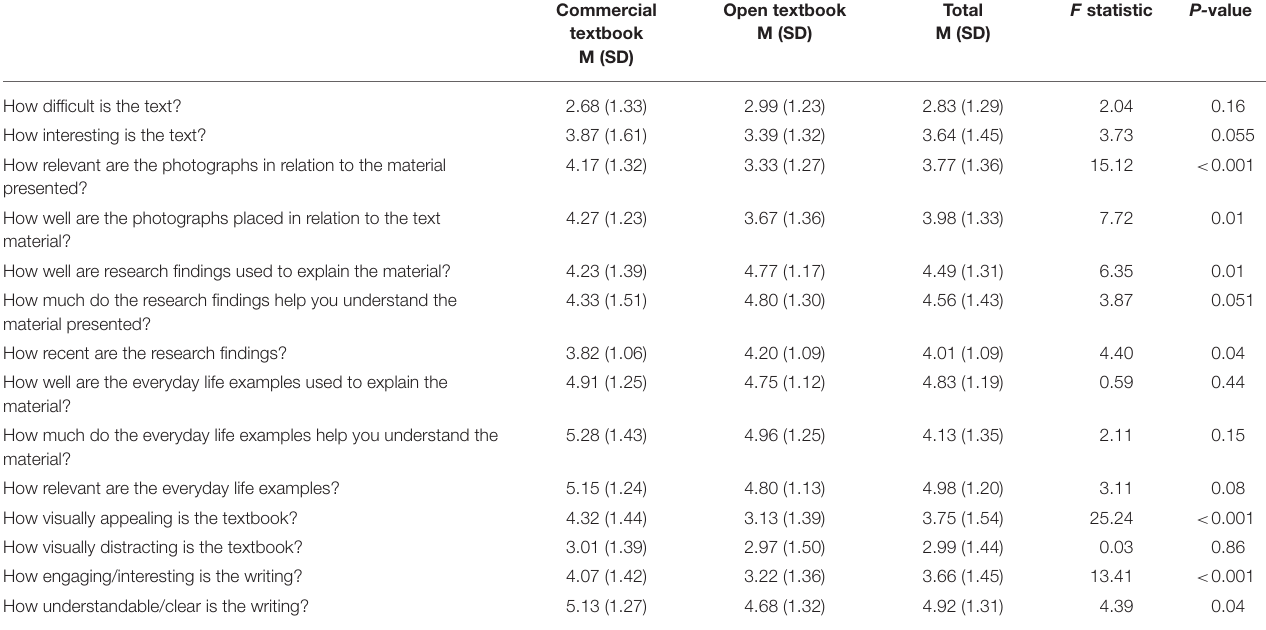
TABLE 1 | Perceptions findings by textbook